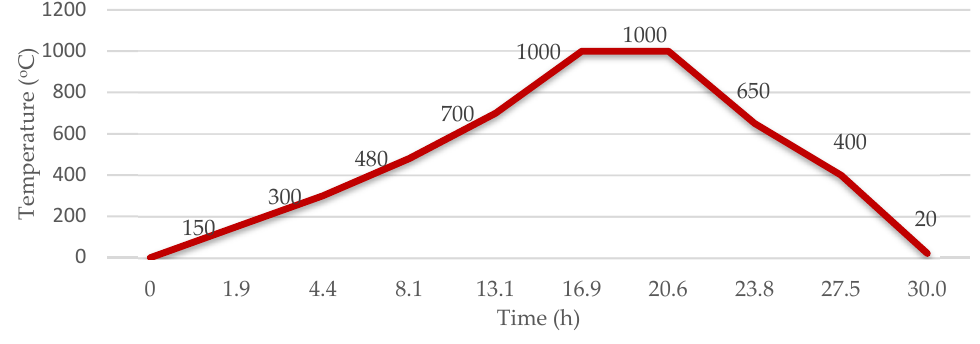
Figure 6. The firing cycle of the brick samples.